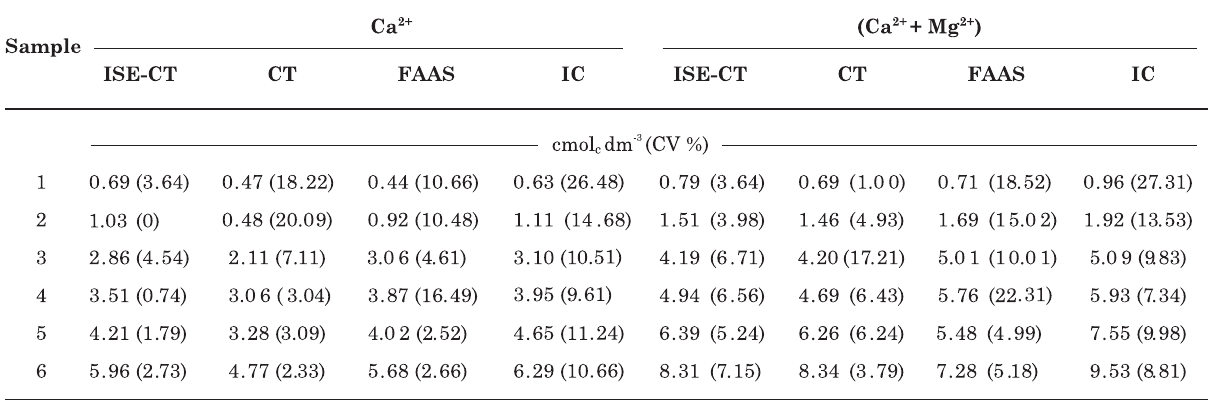
Average (n = 3 for ISE-CT, CT, and FAAS; n = 30 for